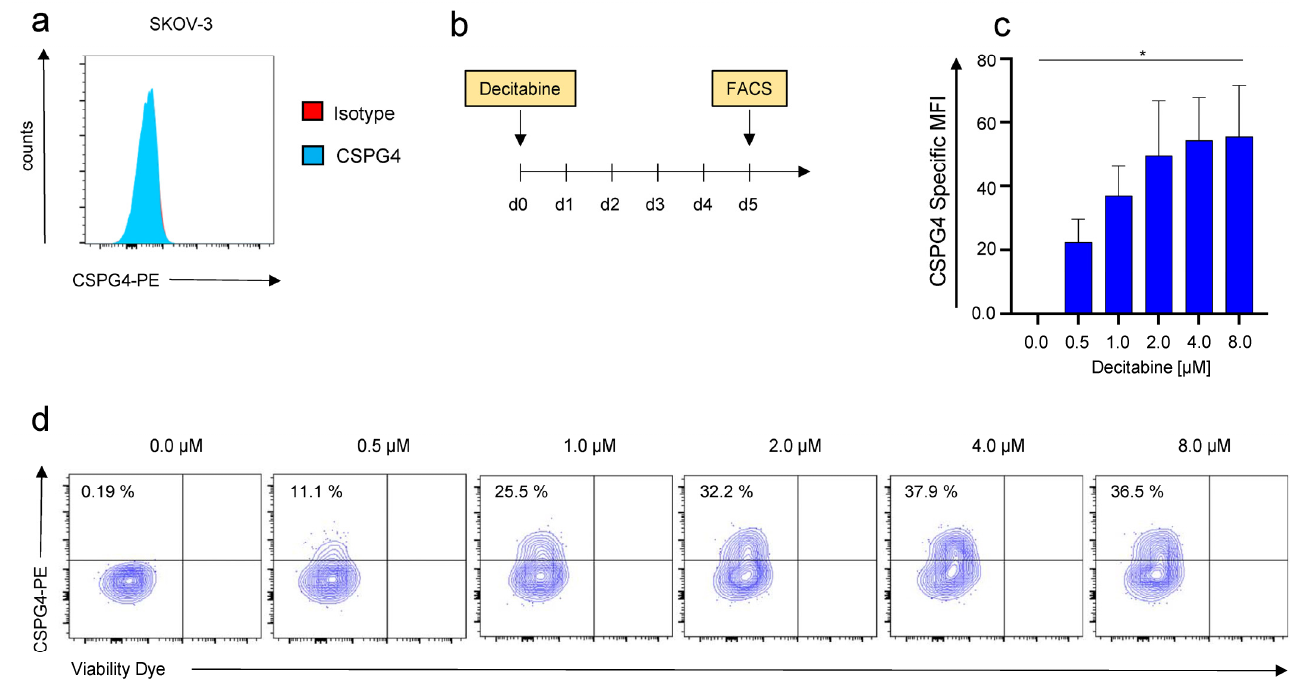
Figure 1. Decitabine-mediated dose-dependent upregulation of CSPG4 on SKOV-3 ovarian cancer cells. ( a ) CSPG4-staining of SKOV-3 ovarian cancer cells using a PE-labeled anti-CSPG4 antibody and a corresponding isotype control. One representative donor out of three experiments is depicted. ( b ) Schematic showing the experimental layout for the decitabine-mediated CSPG4 upregulation. ( c , d ) CSPG4 staining of SKOV-3 ovarian cancer cells 5 days after addition of decitabine at the indicated concentrations. ( c ) Data represent geometric means ± SEM of three runs, p values were calculated by Student’s t -test, * indicates p ≤ 0.05. ( d ) Contour plots of one representative run out of three independent experiments are depicted.